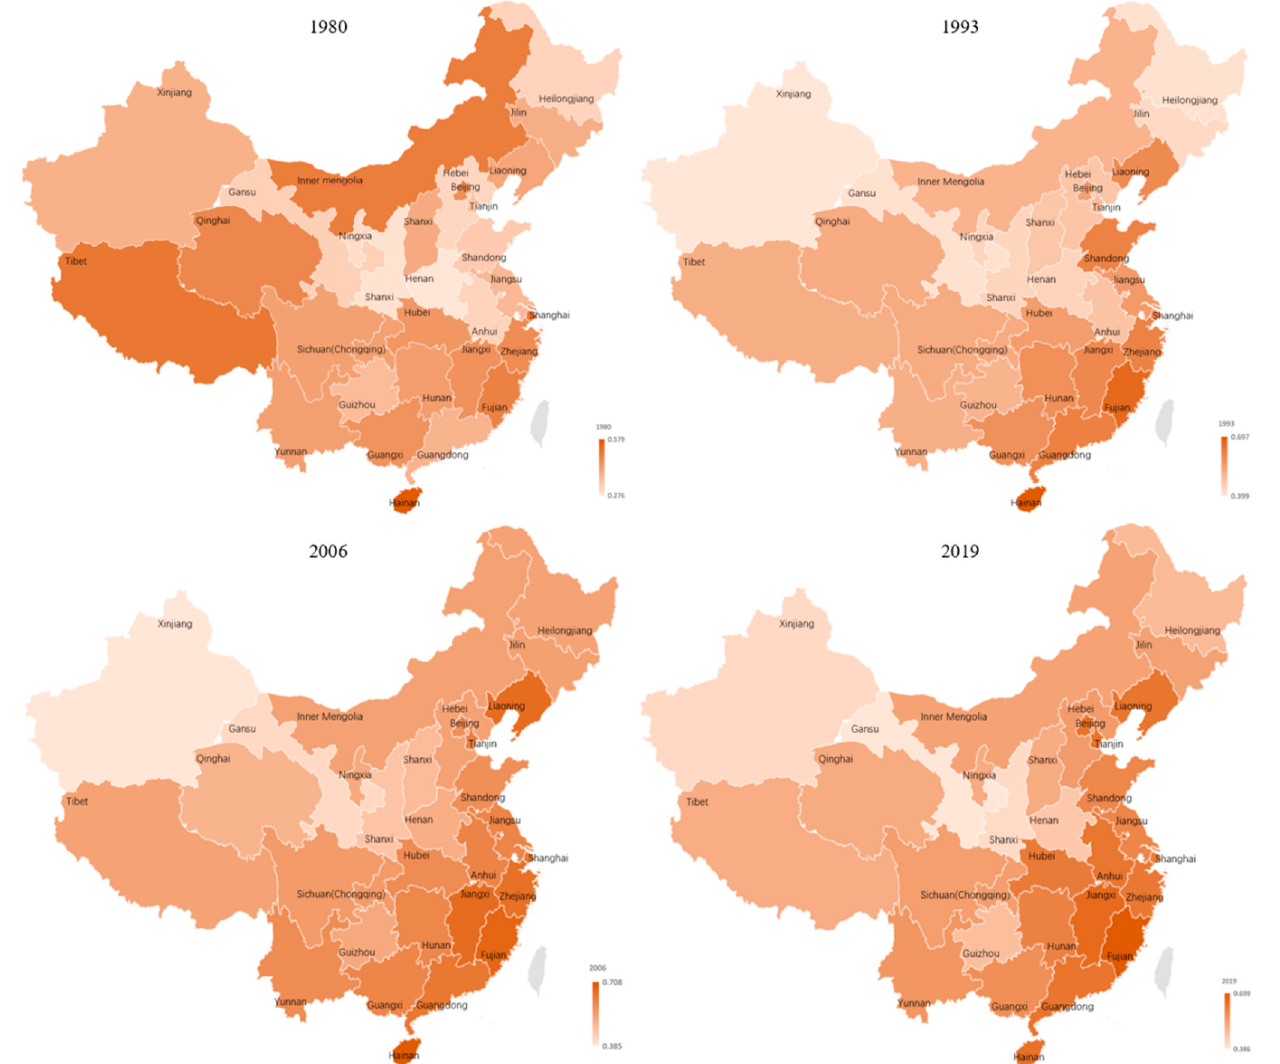
Figure 3. Geographical distribution of AD in China (1980–2019).